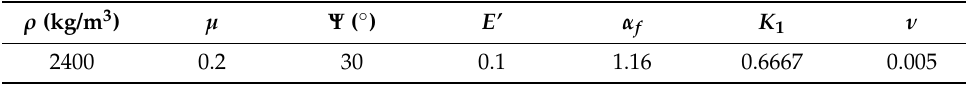
Figure 2. The stress–strain constitutive relationship of different regional partitions: ( a ) concrete in the column; ( b ) concrete in the beam. Table 1. Material parameters of concrete. Table 1. Material parameters of